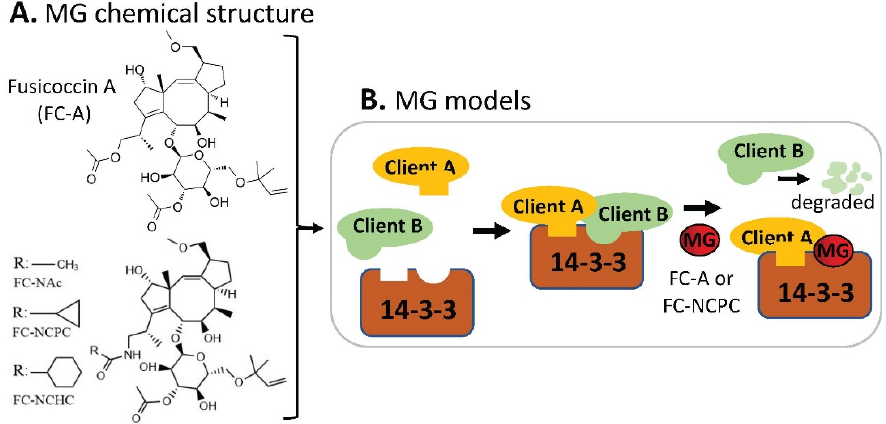
Figure 13. ( A ) Chemical structure of fusicoccin A (FC-A), FC-NAc, FC-NCPC, and FC-NCHC as MG compounds; ( B ) a cartoon model to show the key finding for potential disease treatment. This type of MG compound could strengthen some 14-3-3 clients’ binding to 14-3-3, while disrupting other clients’ binding on 14-3-3 as shown in ( B ).